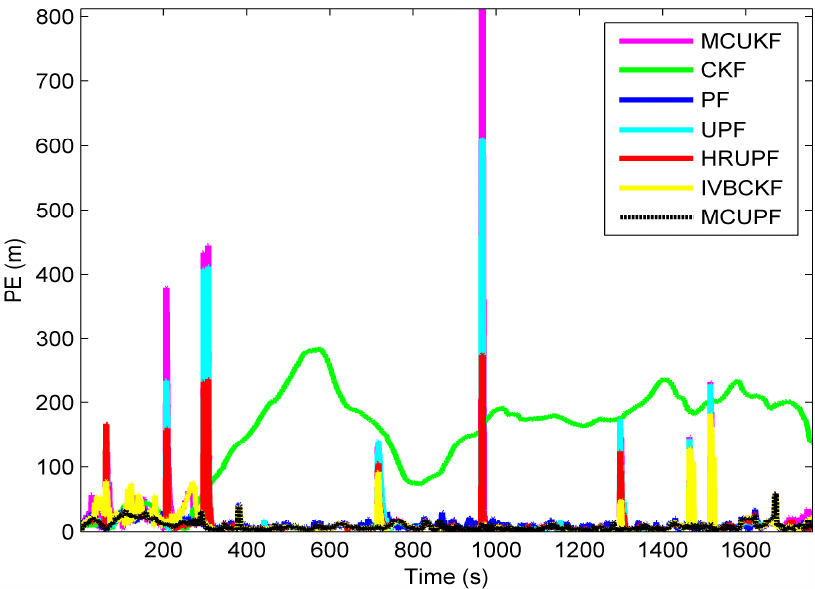
Figure 8. Position of AUV taken by the proposed filter and existing filters.